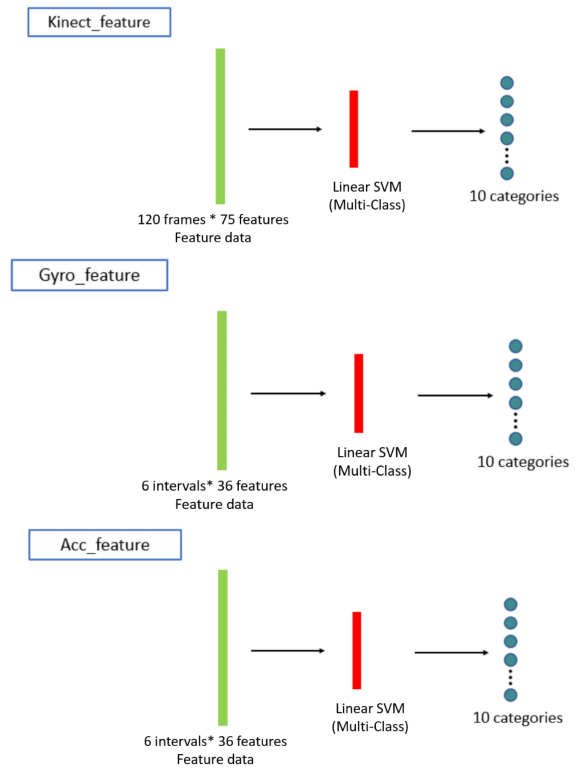
Figure 12. The training process for the behavior classifiers for a SVM-based scheme for performance